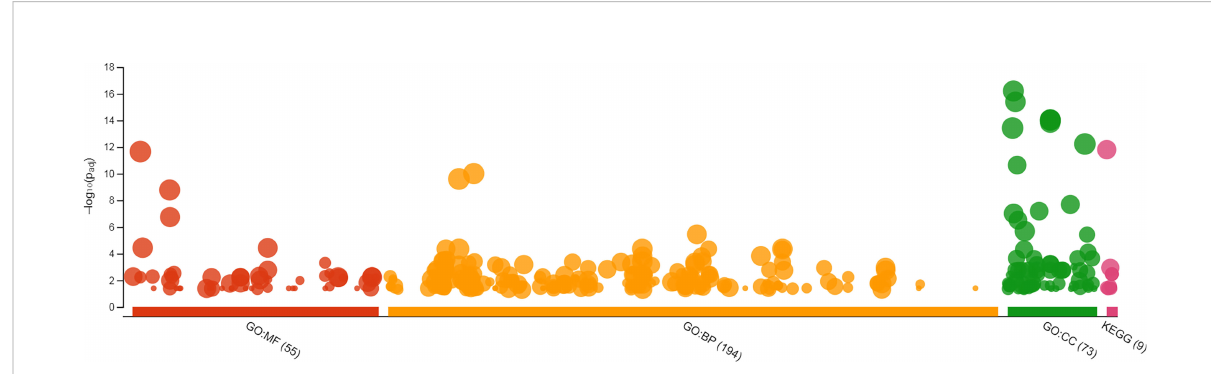
FIGURE 3 GO enrichment of saf fl ower cDNAs containing SSR motifs by gPro fi ler. The magnitude of signi fi cance of hits in GO enrichment analysis is presented by – log 10 (Padj) on y axis, and the GO terms are presented on x axis. MF, molecular function; BP, biological process; CC, cellular component; KEGG, KEGG, Kyoto Encyclopedia of Genes and